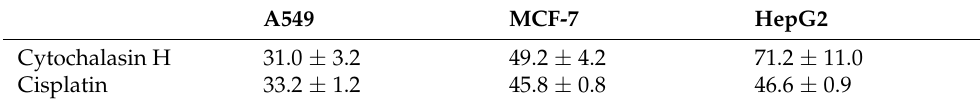
Figure 4. Dose-response curves obtained from viability assay. A549, MCF-7, and HepG2 cells were treated with cytochalasin H or cisplatin at different concentrations for 48 h. Table 1. IC 50 values ( µ M) determined after 48 h